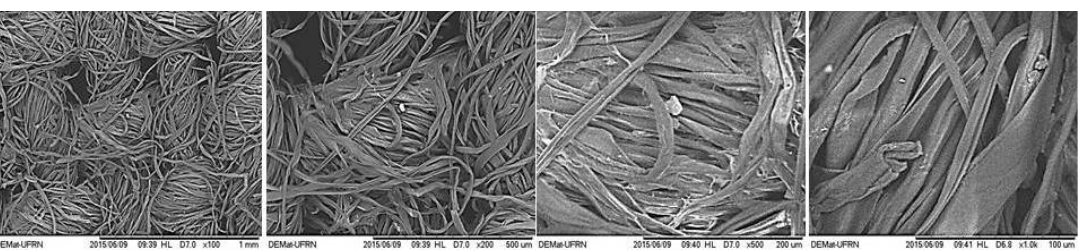
Figure 4. SEM images of fabric bleached with seawater (magnification of 100x, 200x, 500x e 1000x)